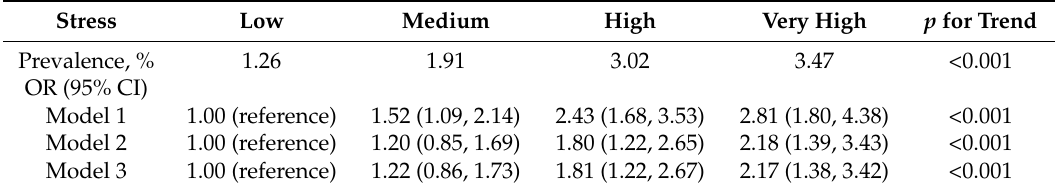
Table 3. Weighted prevalence and odds ratios (95% CI) of atopic dermatitis by self-reported stress. Stress Low Medium High Very High p for